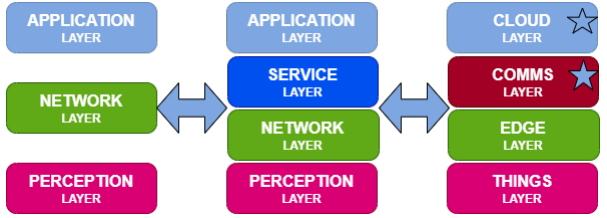
Figure 2. Evolution of the Internet of Things (IoT) architecture for smart agro.